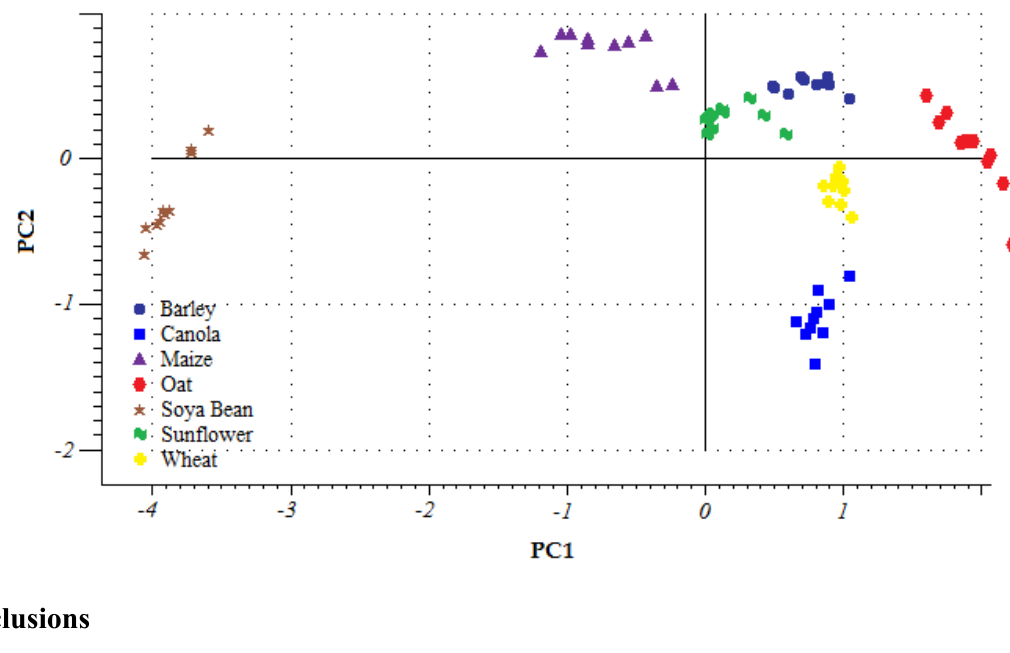
Figure 4. PCA score plot of the different seed samples with respect to PC1 and